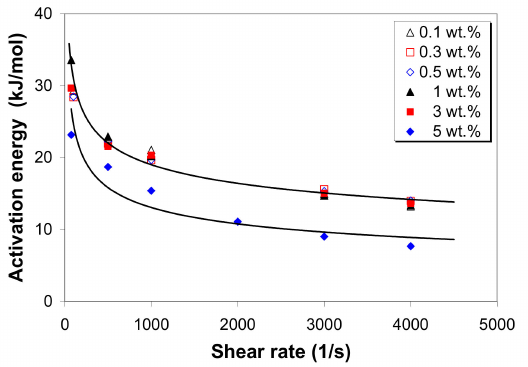
Figure 6. E ff ects of the shear rate and MWCNTs on the flow activation energy of LDPE / MWCNT composites.